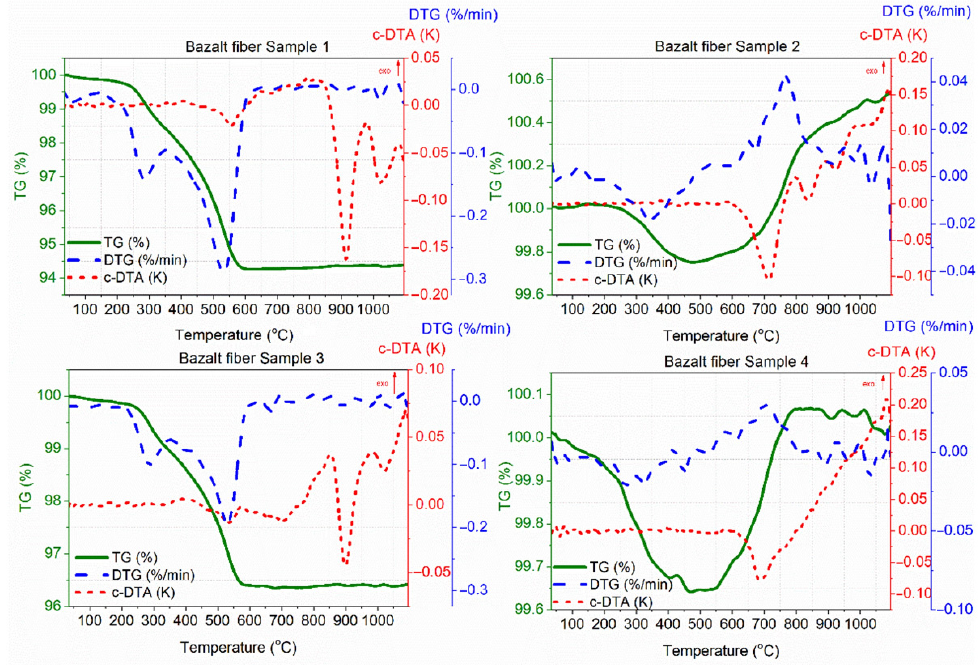
Figure 4. The results of thermogravimetric analysis of samples Nos. 1–4.